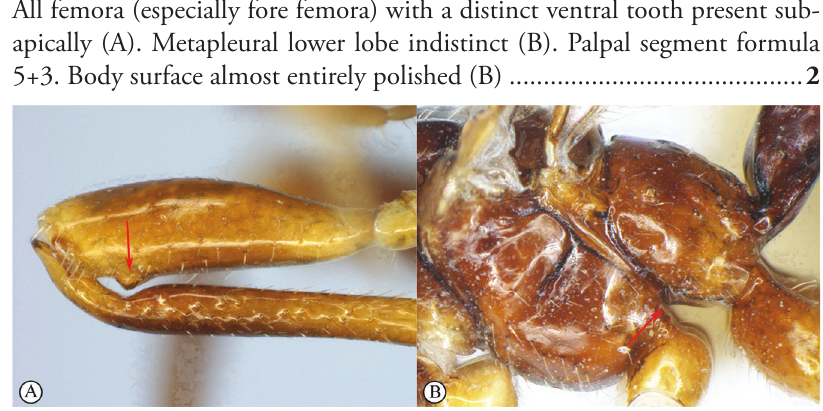
– All femora without a ventral tooth subapically (a). Metapleural lower lobe distinctly projected (b). Palpal segment formula 6+4. Body surface at least